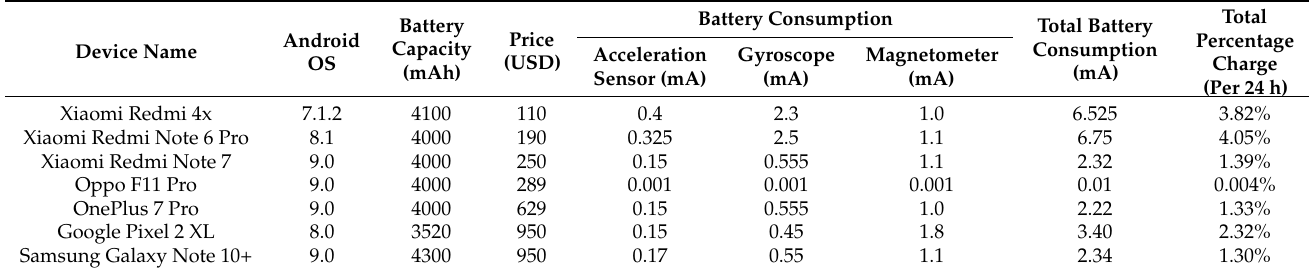
Table 3. A comparison of battery consumptions of the sensors on various